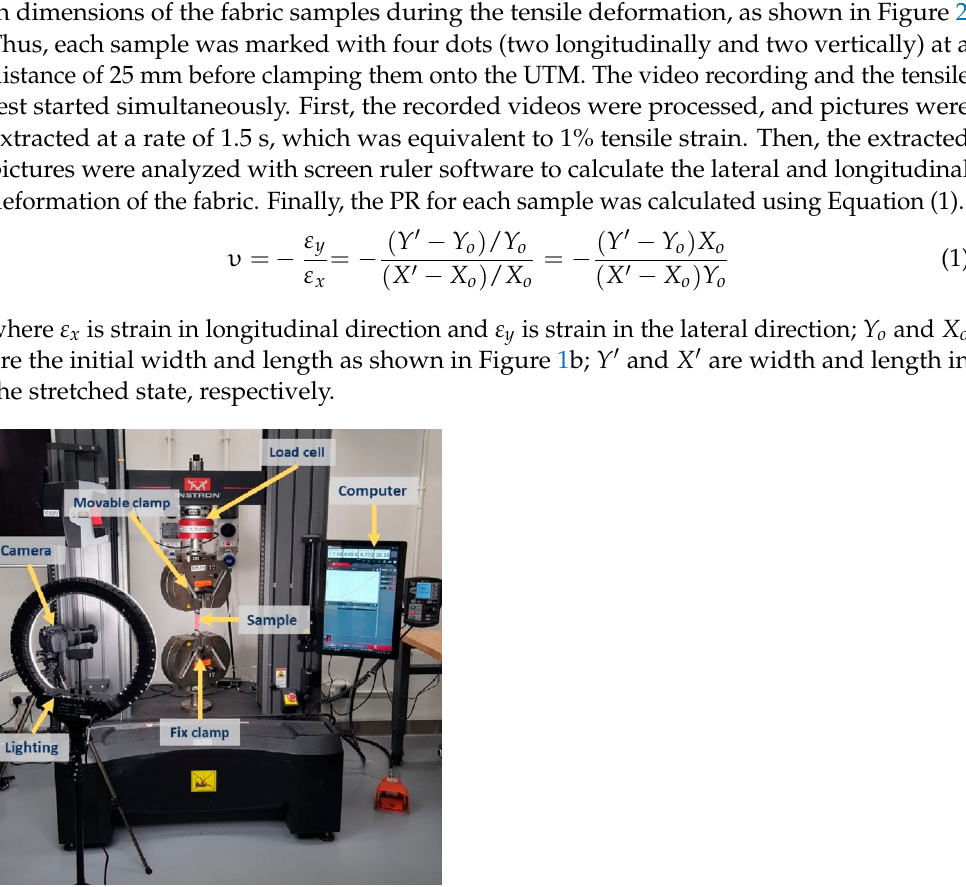
Figure 2. Testing setup on a universal testing machine for Poisson’s ratio measurement.